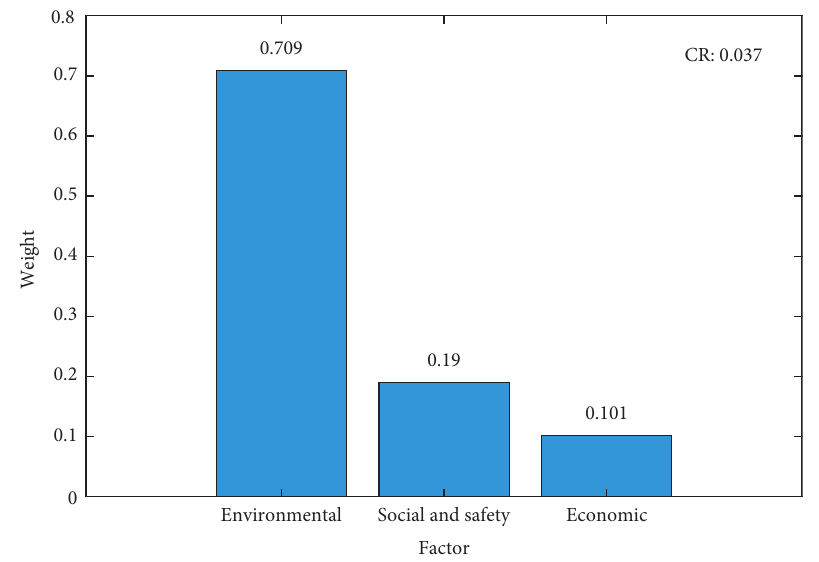
Figure 8: The weights on each factor using